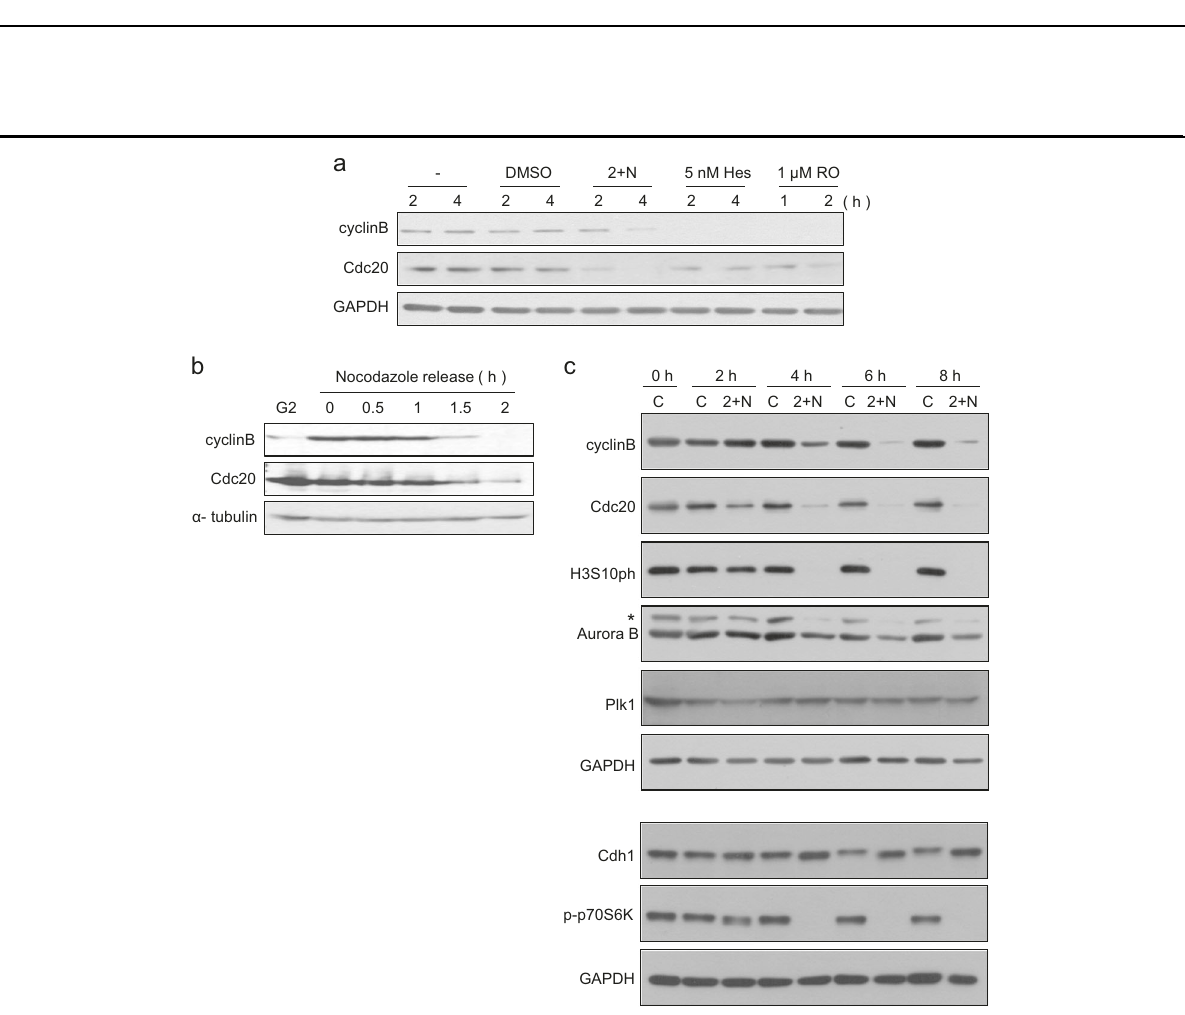
(see fi gure on previous page) Fig. 2 Mitotic slippage via APC/C-dependent degradation of cyclin B. a Mitotic arrested cell lysates from the indicated times after treatment with/without 2-DG and NaN 3 were subjected to western blot analysis using antibodies for cyclin B, securin, and actin (loading control). b Cell arrested in mitosis were transfected with GFP-cyclin B and treated with/without 2-DG and NaN 3 in the presence of nocodazole. Time-lapse images of cyclin B degradation are representative of 36 control cells and 47 cells treated with 2-DG and NaN 3 . Time is presented as minutes after cell rounding up for mitosis. The relative intensity of the GFP-cyclin B signal at different times was measured using NIS-Elements Viewer 4.0 software. The results are shown as the mean (control; black bar, 2-DG and NaN 3 ; white bar). c Cells arrested in mitosis were treated with/without 2-DG and NaN 3 (2 + N) in the absence/presence of MG132. Quanti fi cation of the percentage of mitotic cells with condensed chromosomes was performed by aceto-orcein staining. The results are shown as the mean ± SD from two independent experiments ( n = 100). d Cell lysates from the indicated times after treatment with/without 2-DG and NaN 3 (2 + N) were subjected to western blot analysis using antibodies against cyclin B and actin (loading control). e For APC inhibition, cells arrested in mitosis were treated with 12 μ M proTAME for 30 min prior to co-treatment with/without 2-DG and NaN 3 (2 + N). Quanti fi cation of the percentage of mitotic cells with condensed chromosome was performed by aceto-orcein staining. The results are shown as the mean ± SD from two independent experiments ( n = 100). f Cell lysates from the indicated times after treatment with 2-DG and NaN 3 (2 + N) were subjected to western blot analysis using antibodies for cyclin B and GAPDH (loading